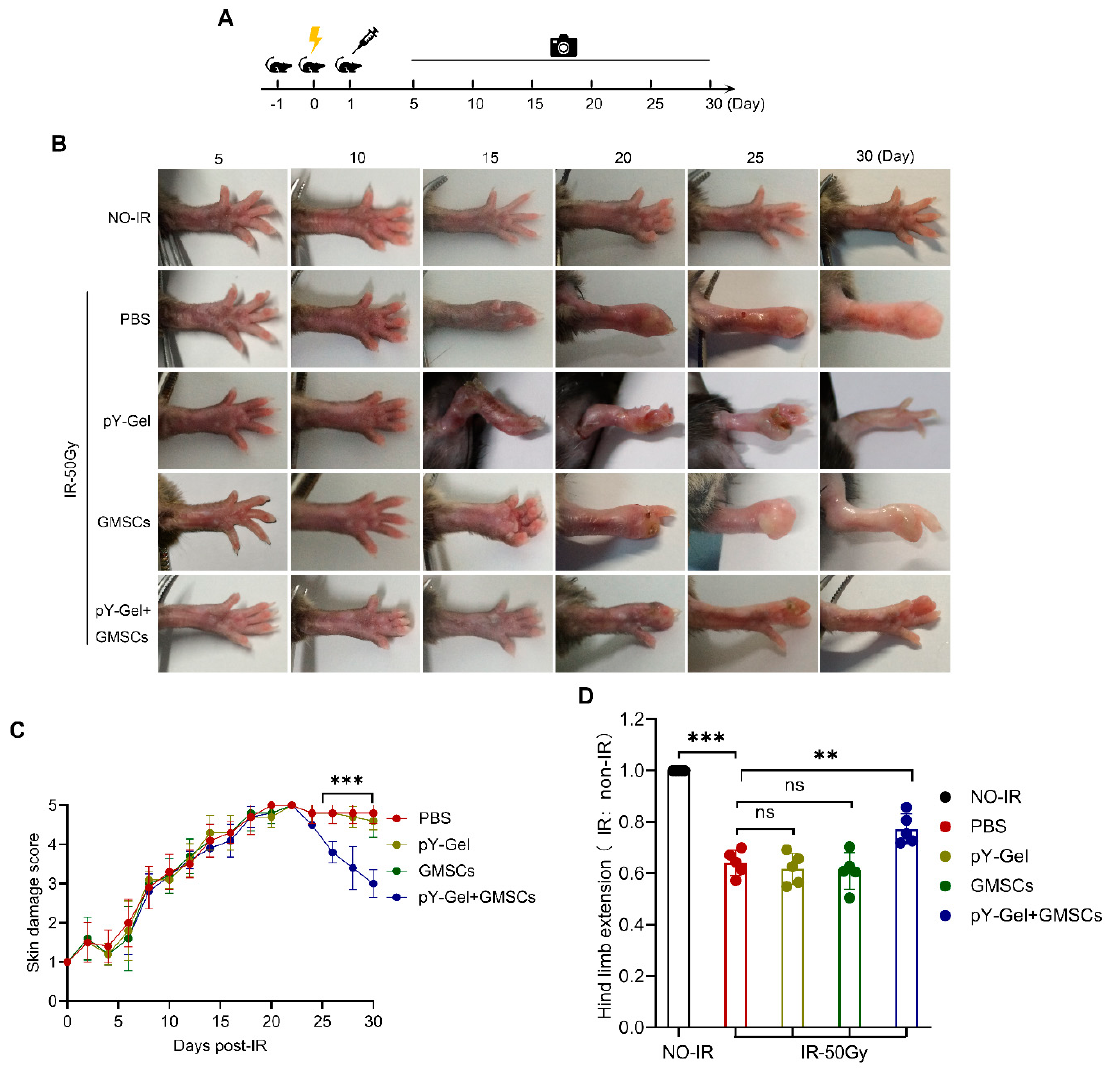
Figure 1. Serial response of mice treated with pY − Gel and GMSCs. ( A ) The flow chart of the development and treatment of a mouse model of CRI. ( B ) Representative images of the left hind limb 5–30 days post-irradiation. ( C ) A 5-point scoring system was used to double-blindly evaluate the degree of skin damage every two days. ( D ) Assessment of hind limb extension. n = 5 animals. Data are expressed as the mean ± standard deviation. Statistical comparisons were made by ANOVA for multiple comparisons. ns, not significant p > 0.05, ** p < 0.01 and *** p < 0.001.